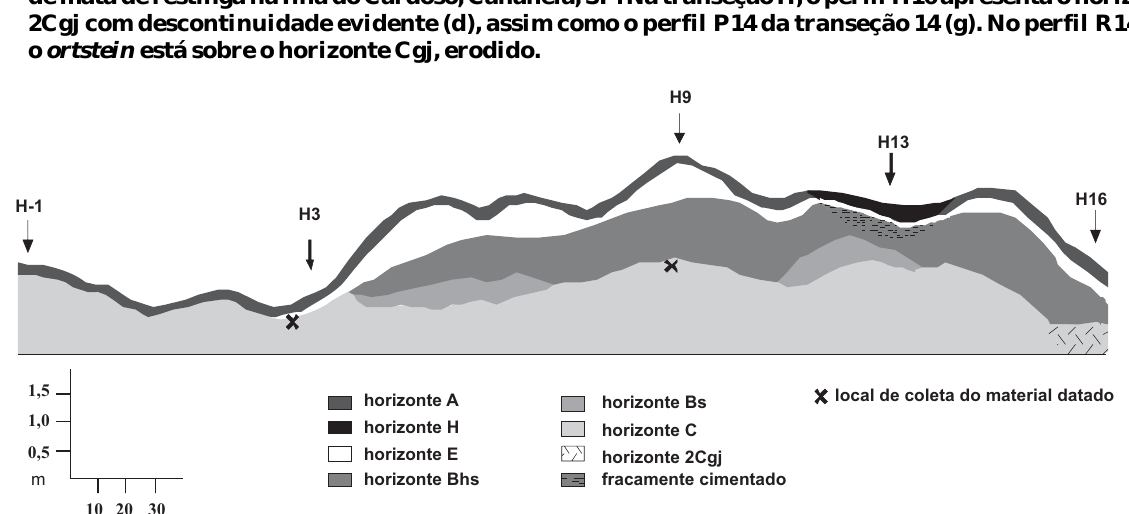
Figura 4. Estrutura da transeção H dos solos estudados sob vegetação de mata de restinga na Ilha do Cardoso, Cananéia